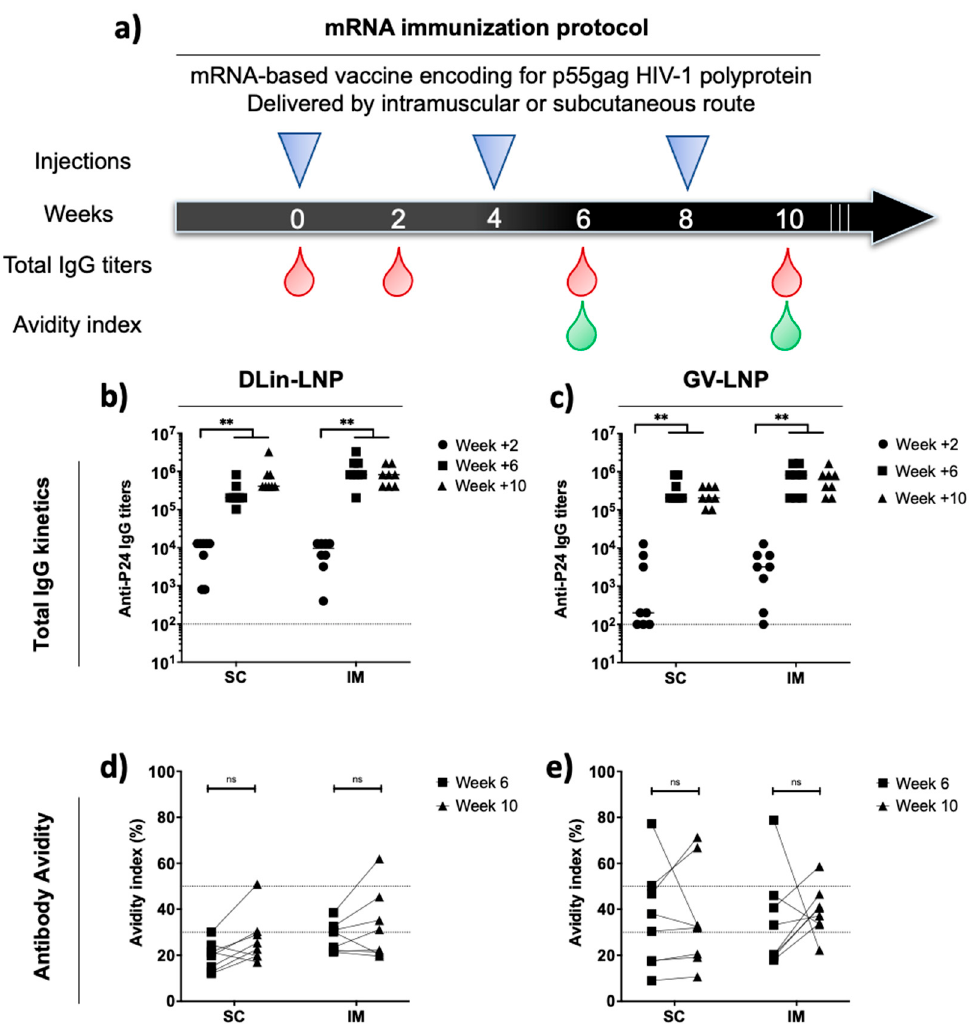
Figure 2. p55Gag mRNA-LNP-based vaccines elicit equivalent IgG titer kinetics with a higher heterogeneity of antibody avidity index for GV-LNP. ( a ) The vaccination schedule: CB6F1 mice received three sequential shots (4 week intervals) of DLin- or GV-LNPs carrying 3 µg of mRNA encoding p55Gag polyprotein. Blood samples were collected at different intervals in order to evaluate IgG titers ( b , c ) and antibody avidity indices ( d , e ) of mice vaccinated with DLin-LNPs ( b , d ) and GV-LNPs ( c , e ). Each point represents an individual mouse. The nonparametric Wilcoxon test was applied to highlight signi fi cant di ff erences ( p > 0.05: NS and p < 0.01 **).